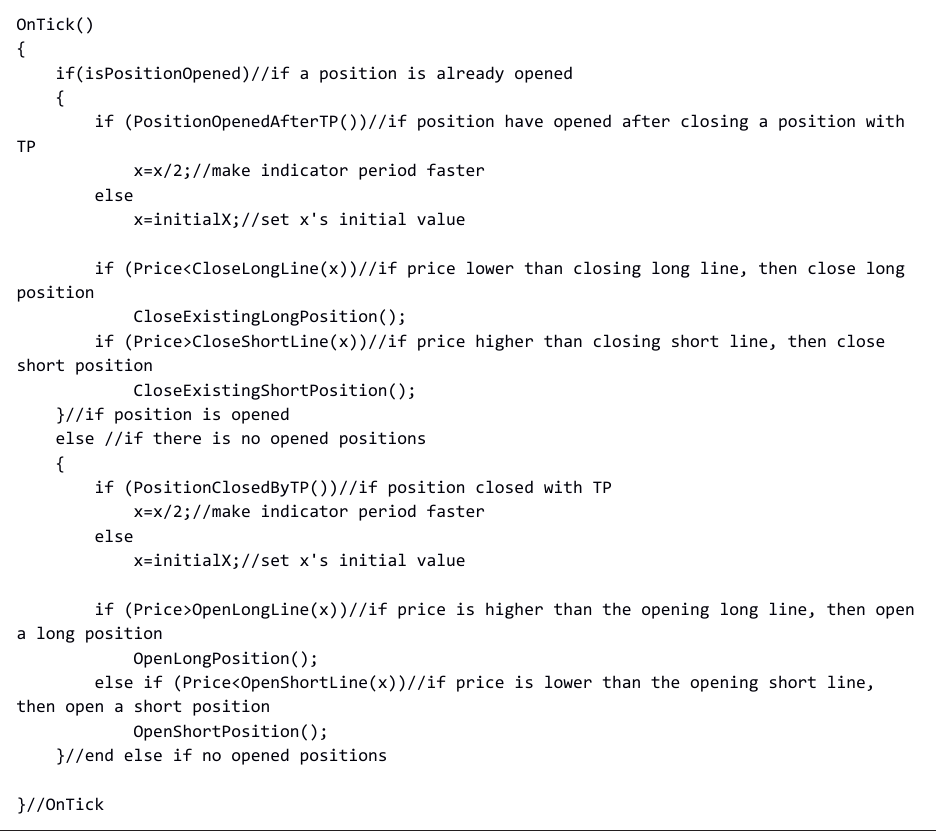
Figure 2. Close position functions (stop loss/take profit)/open position in the system